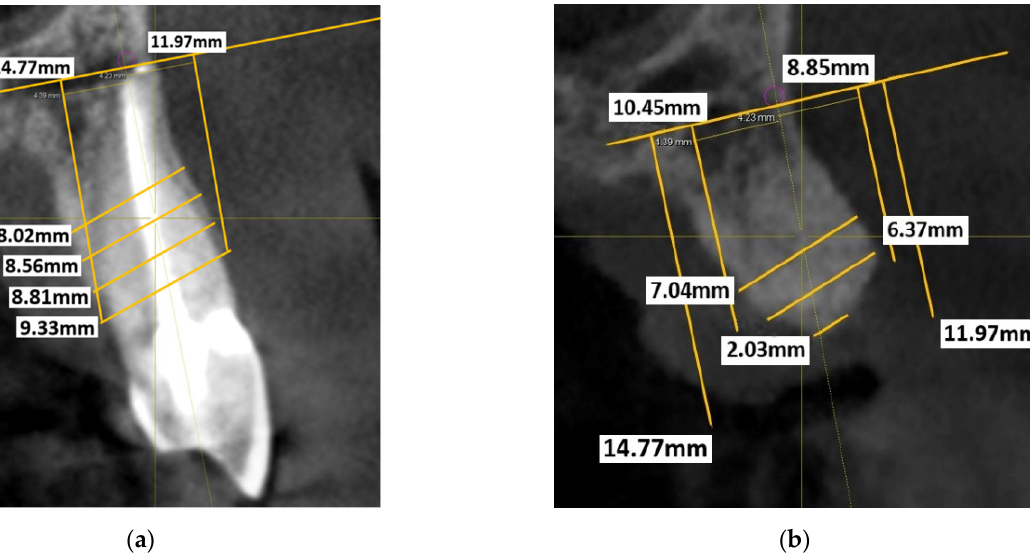
Figure 1. ( a ) Preoperative measurements of left maxillary canine site; ( b ) Postoperative measure- ments of left maxillary canine site. Note the loss of vertical height causing the thickness measure- ments to start at 2 mm below the height of the original crests (outer parallel